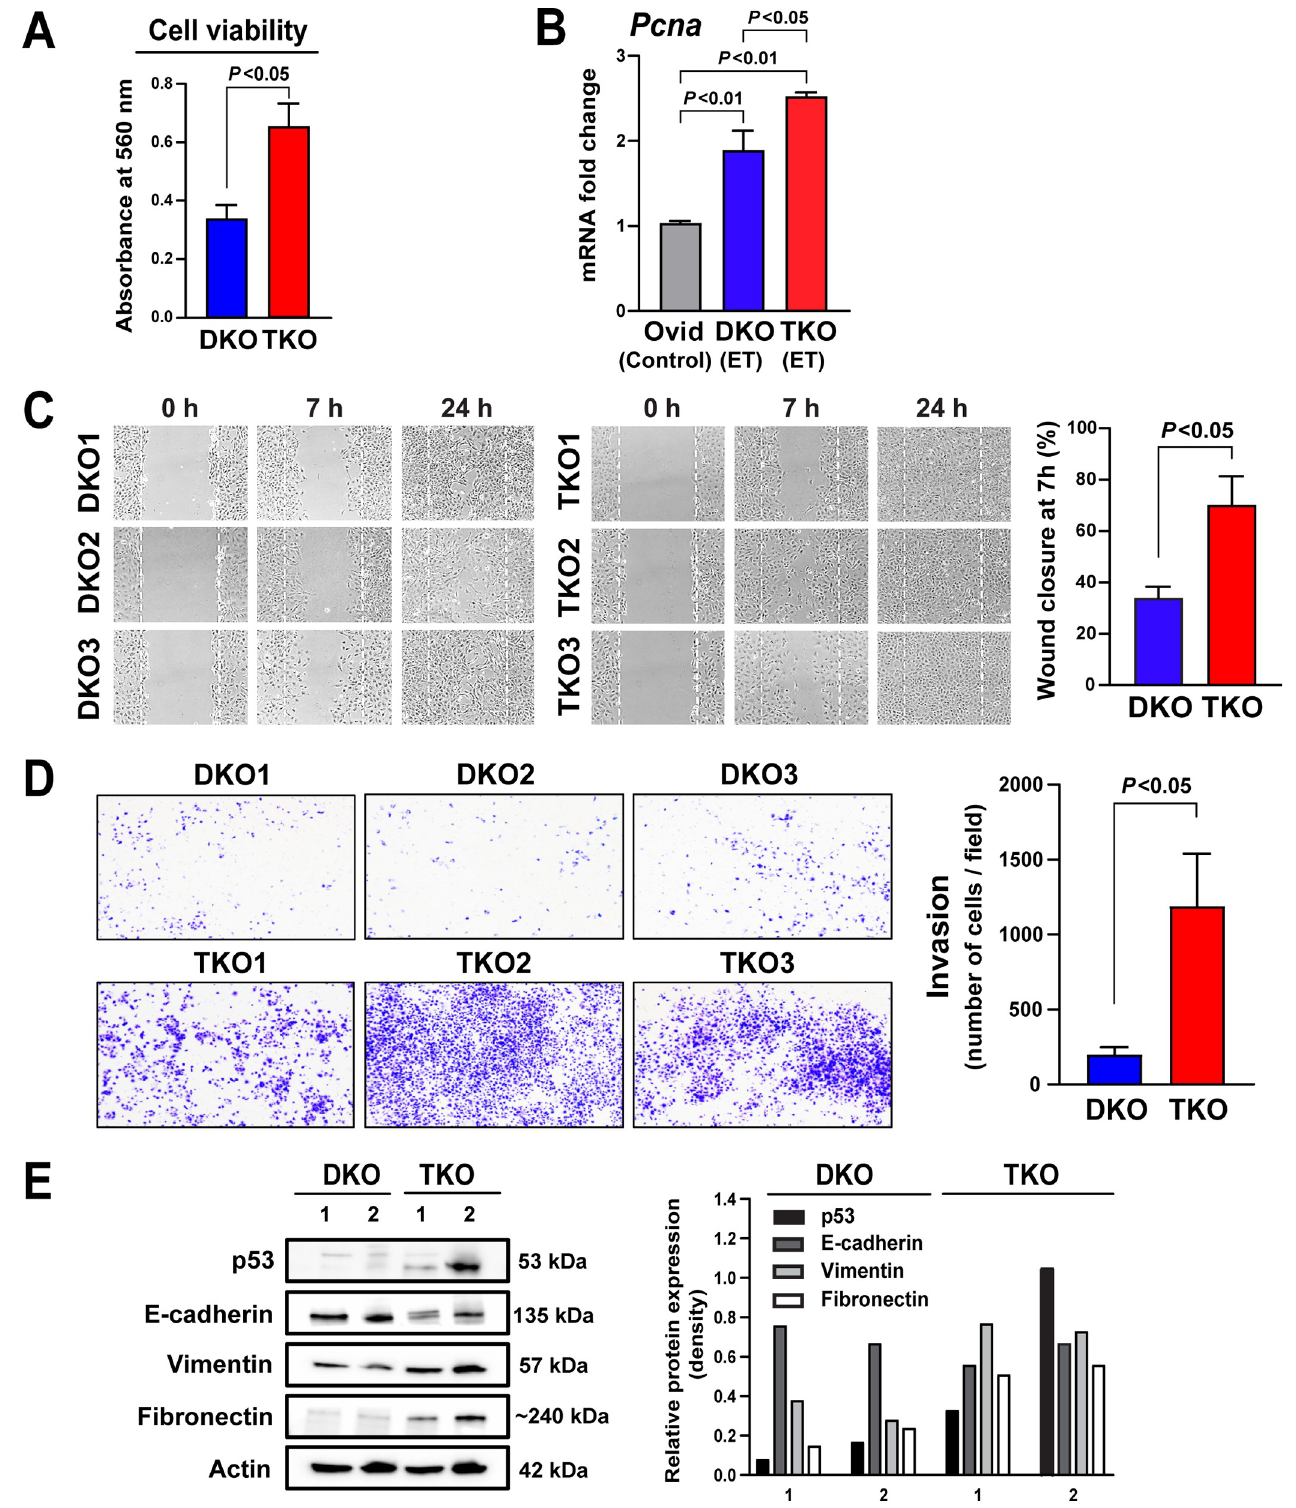
Fig 6. Enhanced proliferation and invasiveness in TKO tumors. A. Cell viability. MTT assay indicates that cell lines derived from TKO HGSC have higher viability and proliferative potential than those derived from DKO HGSC. B. Cell proliferation. Real-time PCR measures mRNA expression levels of Pcna in early-stage tumors (ET) from DKO and TKO mice. Both models show high Pcna levels with a greater increase in TKO tumors. C. Cell migration. Migration